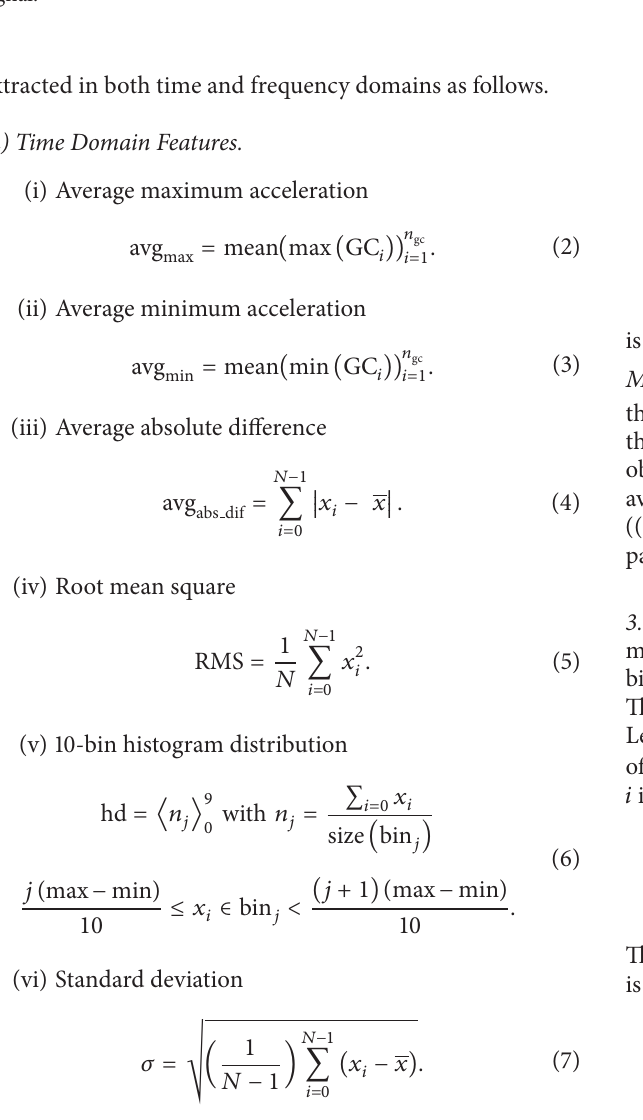
Figure 3: Gait cycle based segmentation on vertical dimension gait